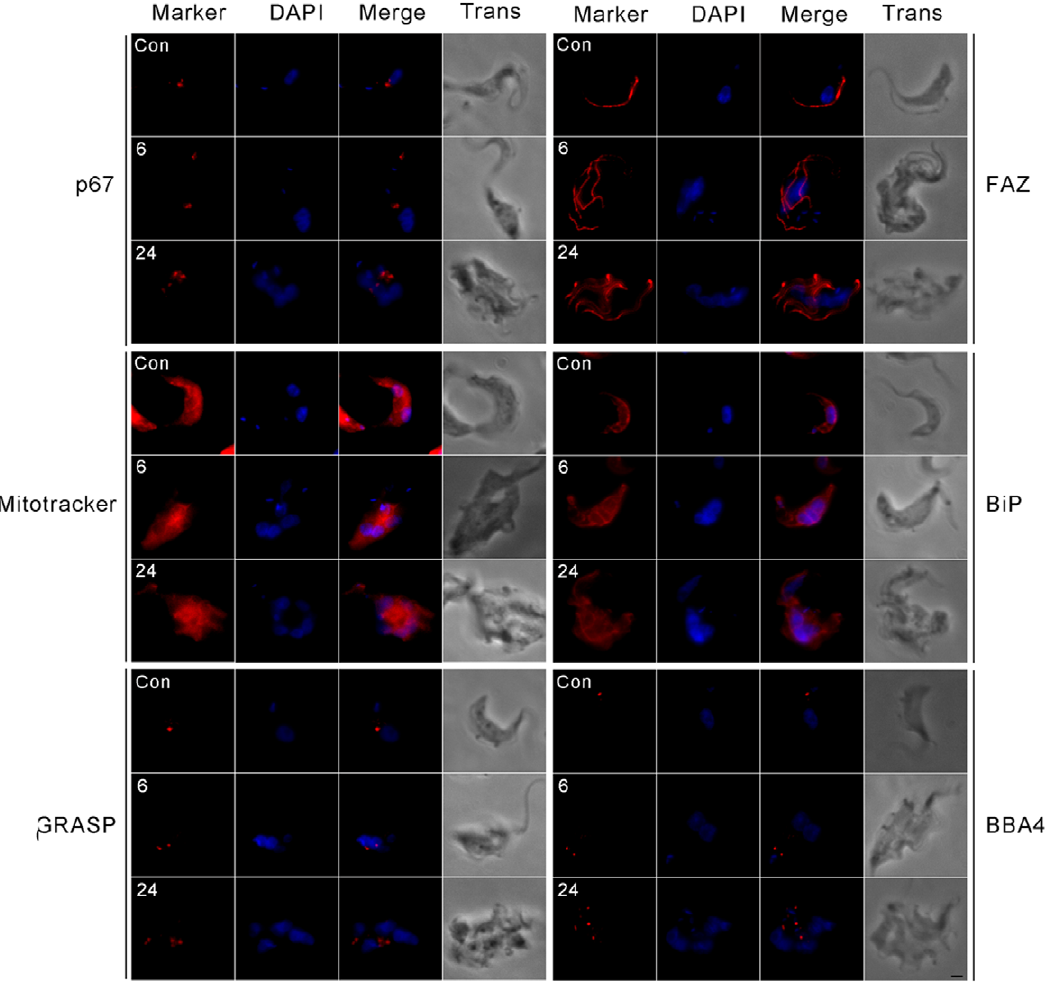
Figure 6. Cellular organelles have normal morphology and appear to replicate and divide normally following TbRHP RNAi. Lysosomes (p67), Golgi complex (GRASP), mitochondria (Mitotracker), endoplasmic reticulum (BiP), basal bodies (BBA4), and flagella (FAZ) were inspected in knockdown cells compared to control cells at 6 hours and 24 hours after the induction of RNAi. All organelles examined appeared morphologically normal and appeared to divide normally with respect to the number of total nuclei in a cell. Bar, 2 m